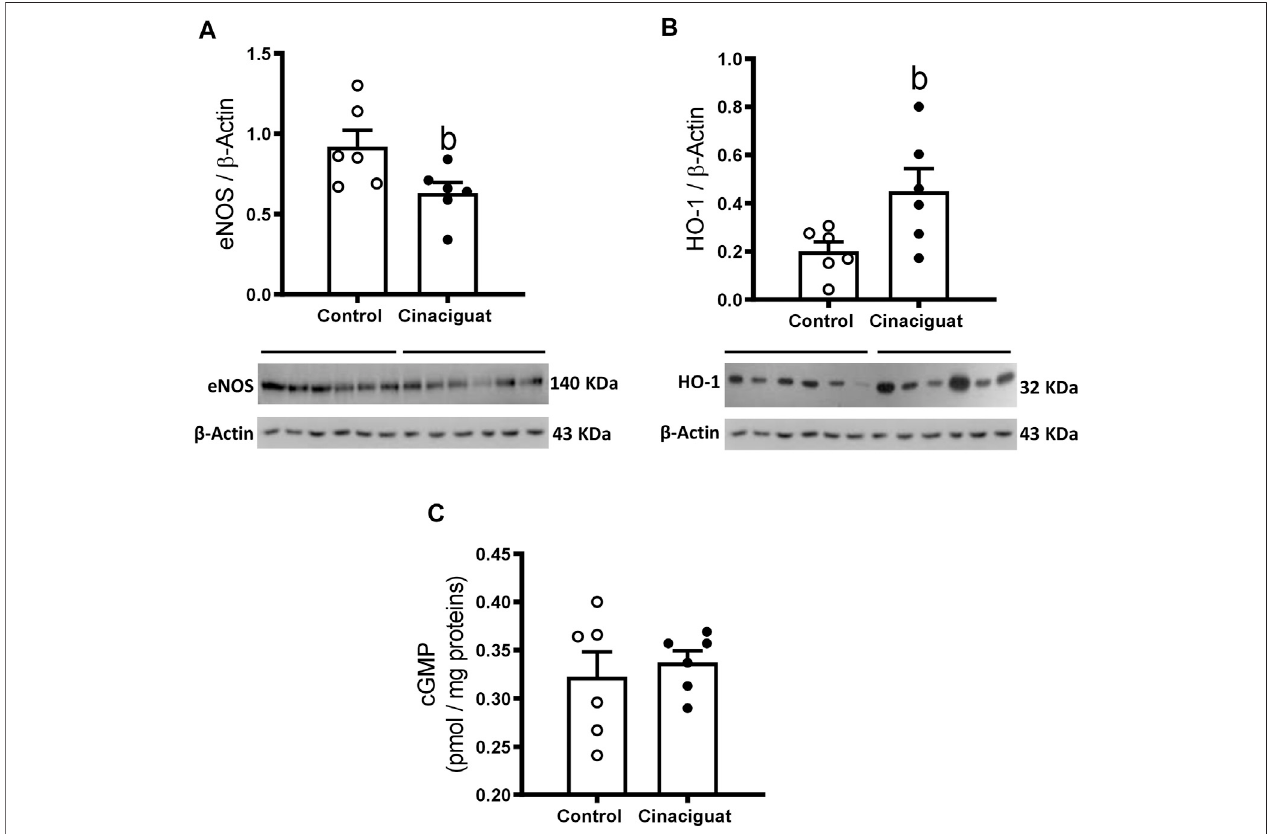
FIGURE 8 | Effect of Cinaciguat treatment on pulmonary expression of vasodilatory pathway proteins and cGMP content in lung tissue in chronically hypoxic and pulmonary hypertensive neonatal lambs. WB of eNOS/ β -Actin (A) , HO-1/ β -Actin (B) , and cGMP (pmol/mg proteins) (C) . The β -Actin image was re-used for illustrative purposes.Control(Opencircles, n =6)andCinaciguat-treatedlambs(Blackcircles, n =6).Valuesaremeans±SEM.Signi fi cantdifference( p ≤ 0.05):bvs.Controlgroup.